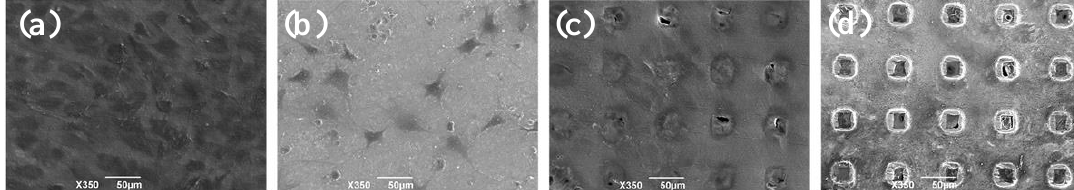
Figure 5. SEM images of MC3T3-E1 cells seeded on the blank scaffold and titanium membrane for 30 consecutive days. ( a ) MC3T3-E1 cells were seeded on the blank scaffold. ( b ) The opposite side of ( a ). ( c ) MC3T3-E1 cells were seeded on the head side of the Ti membrane. ( d ) The opposite side of ( c ) (scale bar represents 50 μm).